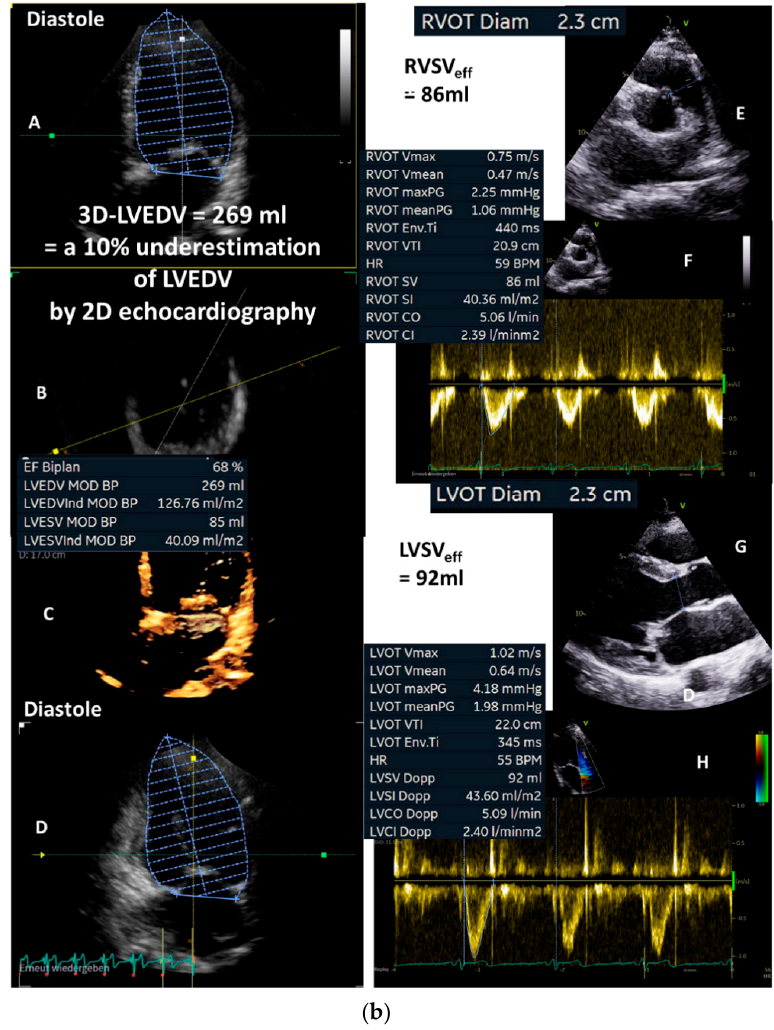
Figure 3. ( a ): Illustration of underestimation of LVEDV and LVESV by 2D echocardiography: in ( A ), the planimetry of LVEDV in the two-chamber view (2-ChV) is shown; in ( B ), the corresponding LVESV is shown. In ( C ), the planimetry of LVEDV in the four-chamber view (4-ChV) is shown; in ( D ), the corresponding LVESV is shown. However, the obvious difference between the longitudinal LV axis in the 4-ChV between diastole and systole indicates the foreshortening of the 4-ChV causing errors of LV volume assessment. LVSV = left ventricular stroke volume, LVSV tot = total LVSV, LVSV eff = effective LVSV, LVEDV = left ventricular end diastolic volume, and LVESV = left ventricular end systolic volume. ( b ): Measurements of the corresponding LVEDV areas in adjusted sectional planes by postprocessing in a 3D dataset in comparison with the 2D echocardiography presented in ( a ): in ( A ), the LVEDV assessment of the adjusted four-chamber view is shown; in ( B ), the perpendicular lines of the apical planes in the short-axis view of the 3D dataset are shown; in ( C ), the 3D view of the azimuth plane is shown; in ( D ), the LVEDV assessment of the adjusted two-chamber view is shown. In ( E ), a parasternal short-axis view during systole to label the RVOT is shown. In ( F ), the RVOT-pw-Doppler spectrum is shown. In ( G ), a parasternal long-axis view during systole to label the LVOT is shown. In ( H ), the LVOT-pw-Doppler spectrum is shown. Estimation of effective LVSV is performed with pw Doppler echocardiography by determination of forward RVSV. In isolated mitral regurgitation, a countercheck can be performed by assessment of forward LVSV which corresponds to forward RVSV. LVSV = left ventricular stroke volume, RVSV = right ventricular stroke volume, LVSV tot = total LVSV, LVSV eff = effective LVSV, LVEDV = left ventricular end-diastolic volume, RVOT = right ventricular outflow tract, and LVOT = left ventricular outflow tract.